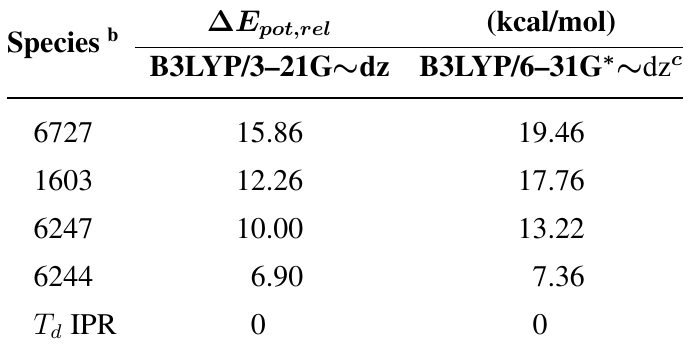
computed a in the B3LYP/3–21G (cid:24) dz pot;rel